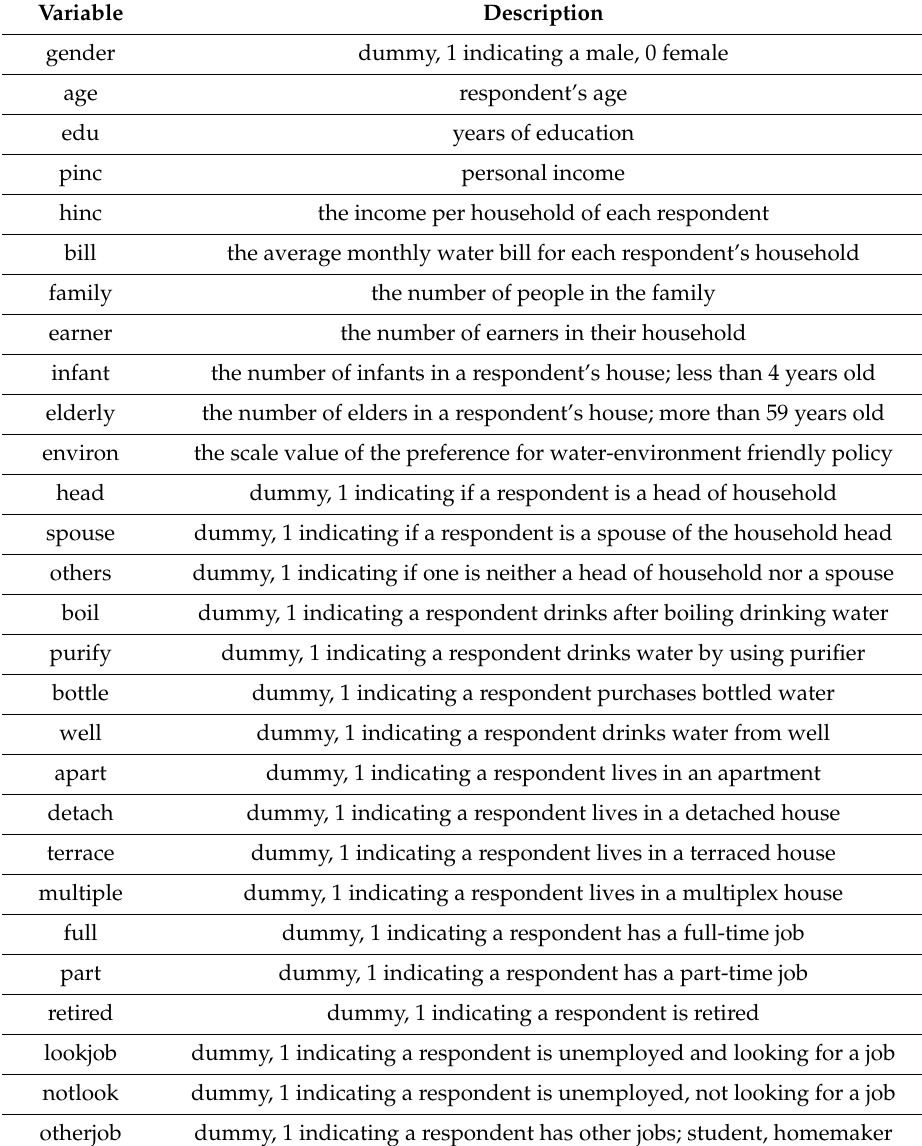
Table A2. Individual specific